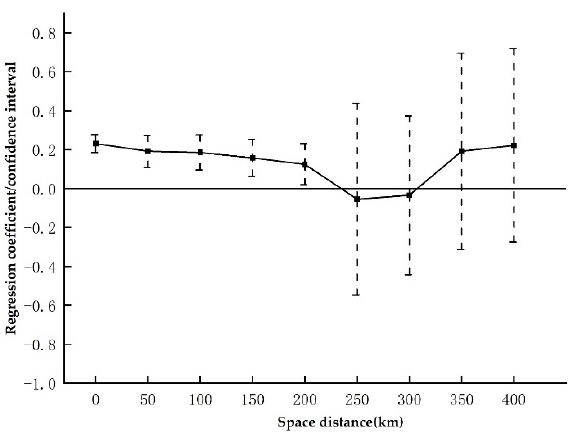
Figure 4. Spatial heterogeneity of low carbon city policy effects.